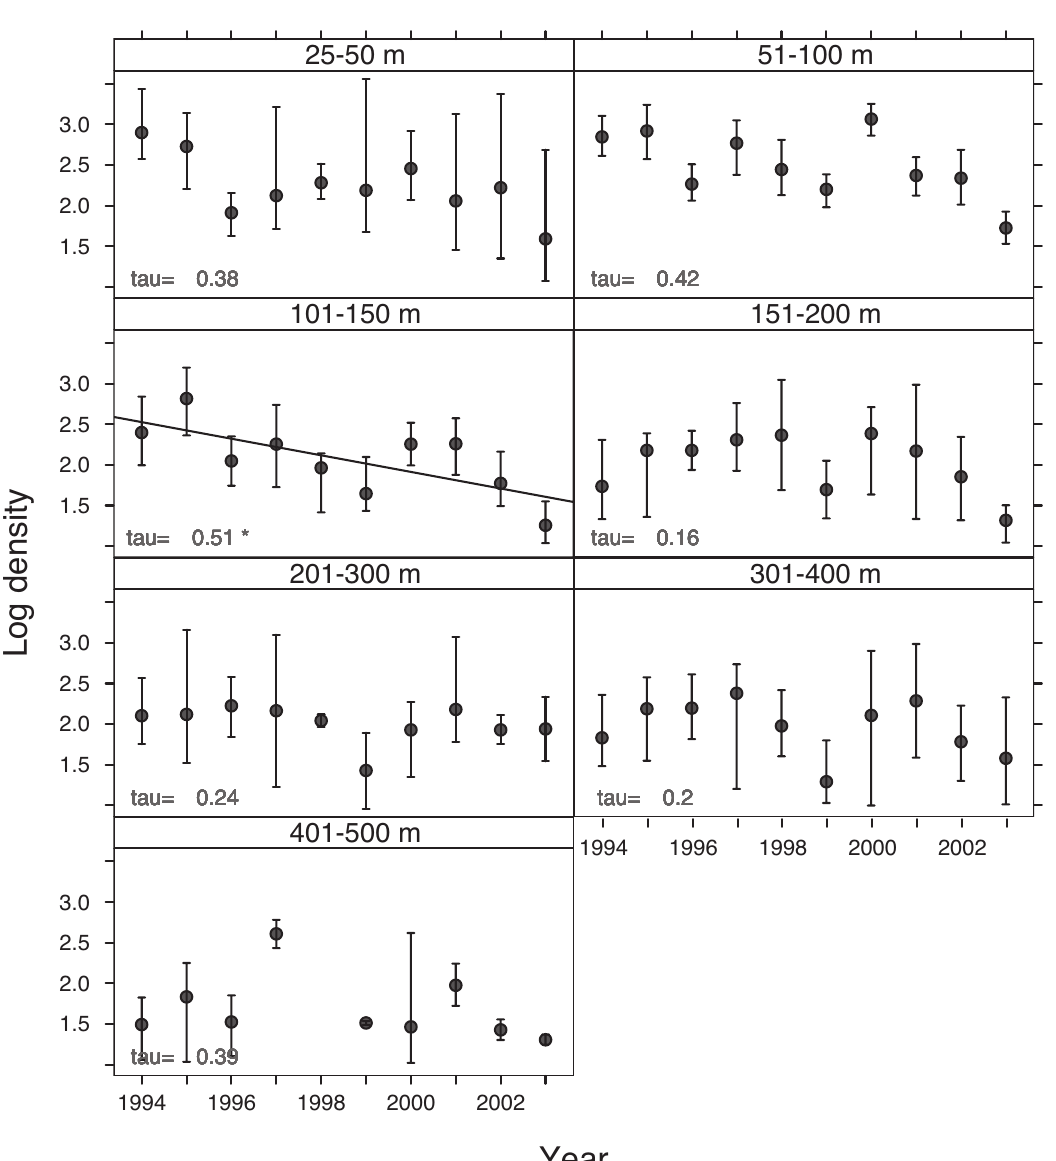
F IG . 10. – Annual variation of Liocarcinus depurator median density (log (crabs · km -2 )) (± CI ) at different depths (only hauls containing 10 95% crabs are used). The value of Kendal’s T is indicated in the bottom left corner of each figure, followed by an * when significant. Lines fitted to significant relationships by least squares regression are merely indicative of the